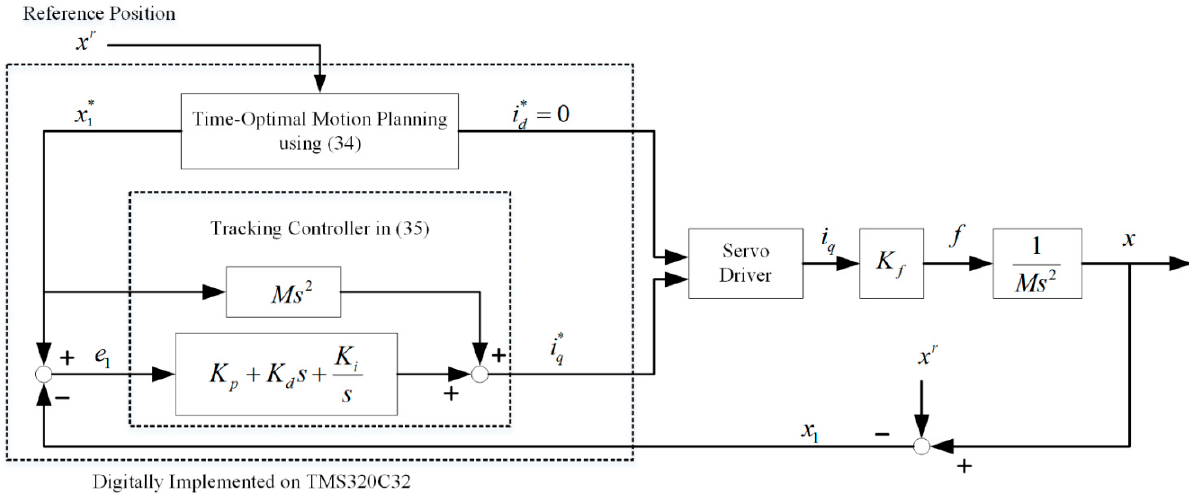
Figure 15. Configuration of the digital signal processor (DSP)-based control system built for an experiment. Reprinted with permission from ref. [100]. Copyright 2003 IEEE.